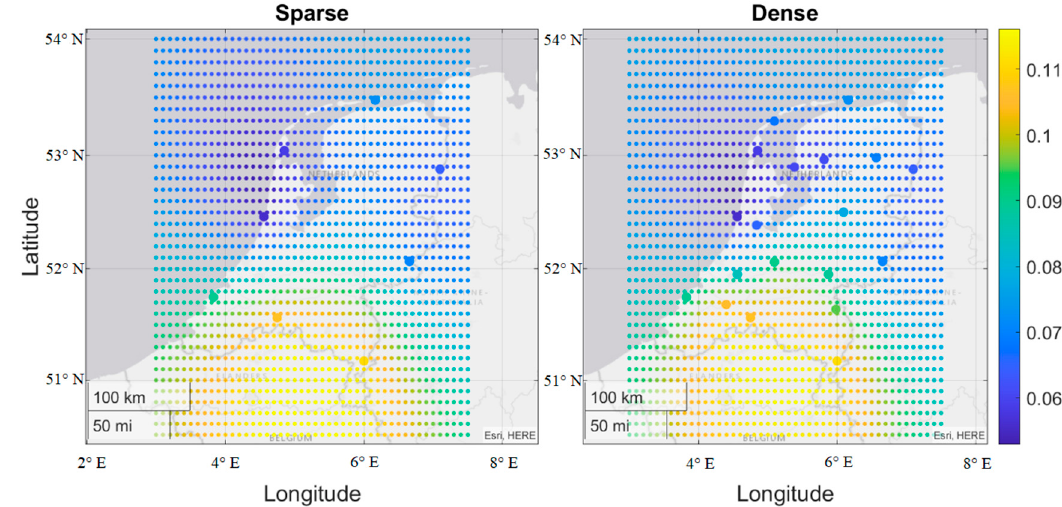
Figure 6. Values of the predicted zenith wet delays at particular locations (the smaller circle) in the local area by using the sparse and dense network (the bigger circle) on 1 February 2019. The unit is m.